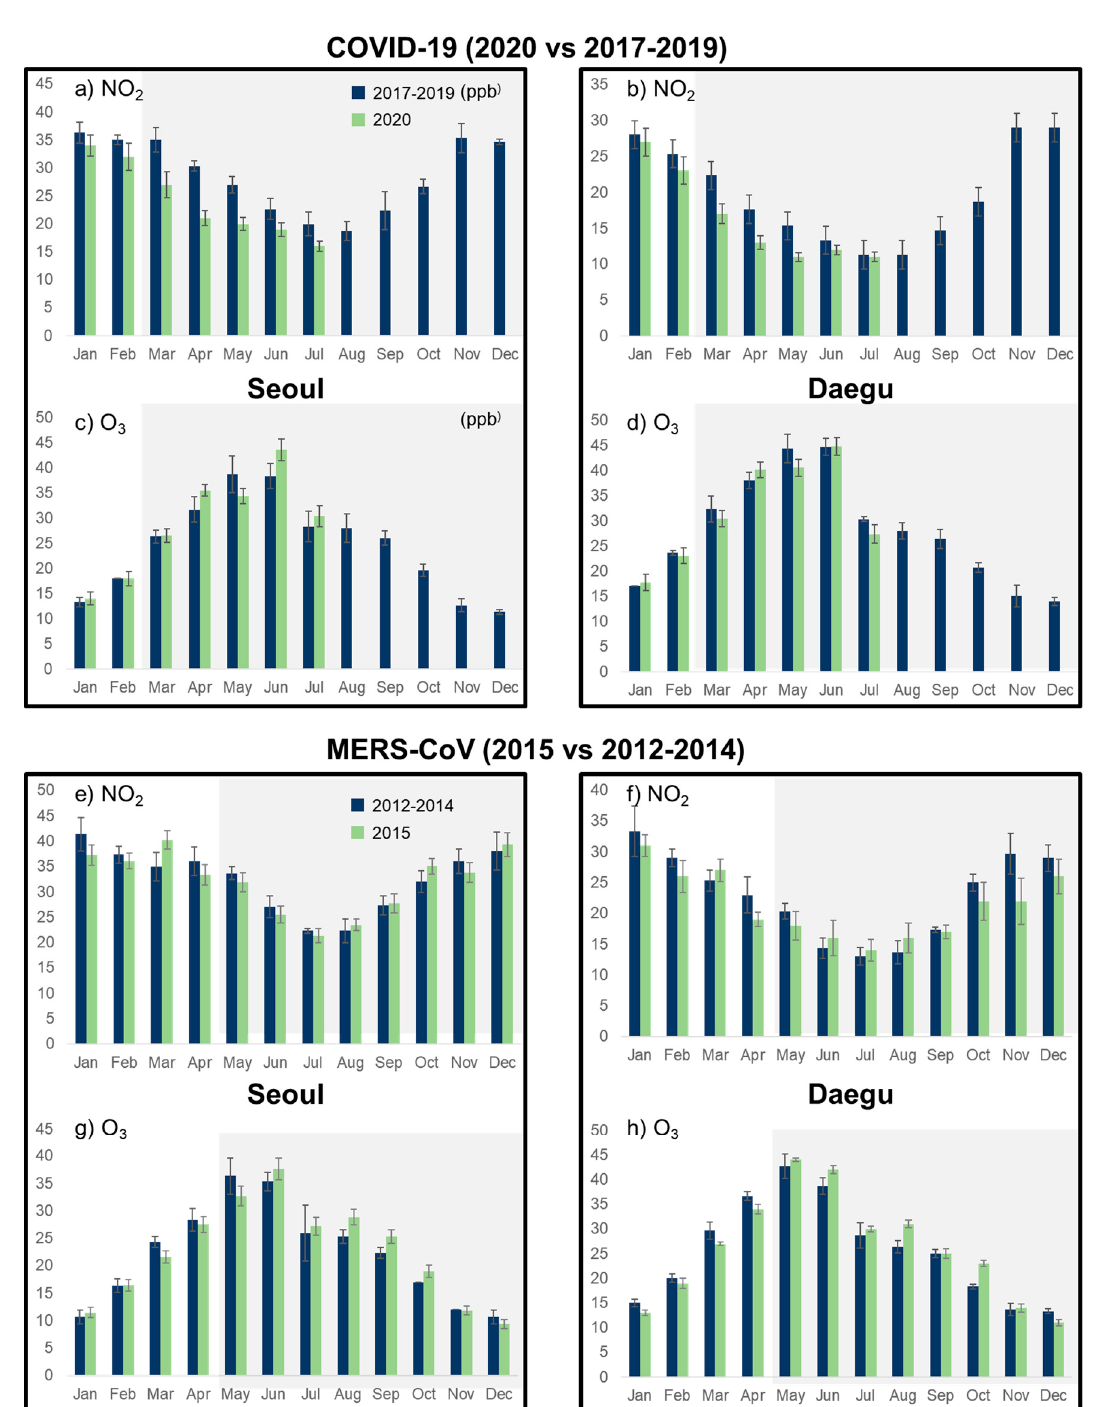
Figure 6. Comparison of NO 2 (ppb) and O 3 (ppb) before and after coronavirus outbreaks. ( a , c ) Changes in NO 2 and O 3 level before and after COVID-19 in Seoul. ( b , d ) Changes in NO 2 and O 3 level before and after COVID-19 in Daegu. ( e , g ) Changes in NO 2 and O 3 level before and after MERS-CoV in Seoul. ( f , h ) Changes in NO 2 and O 3 level before and after MERS-CoV in Daegu.